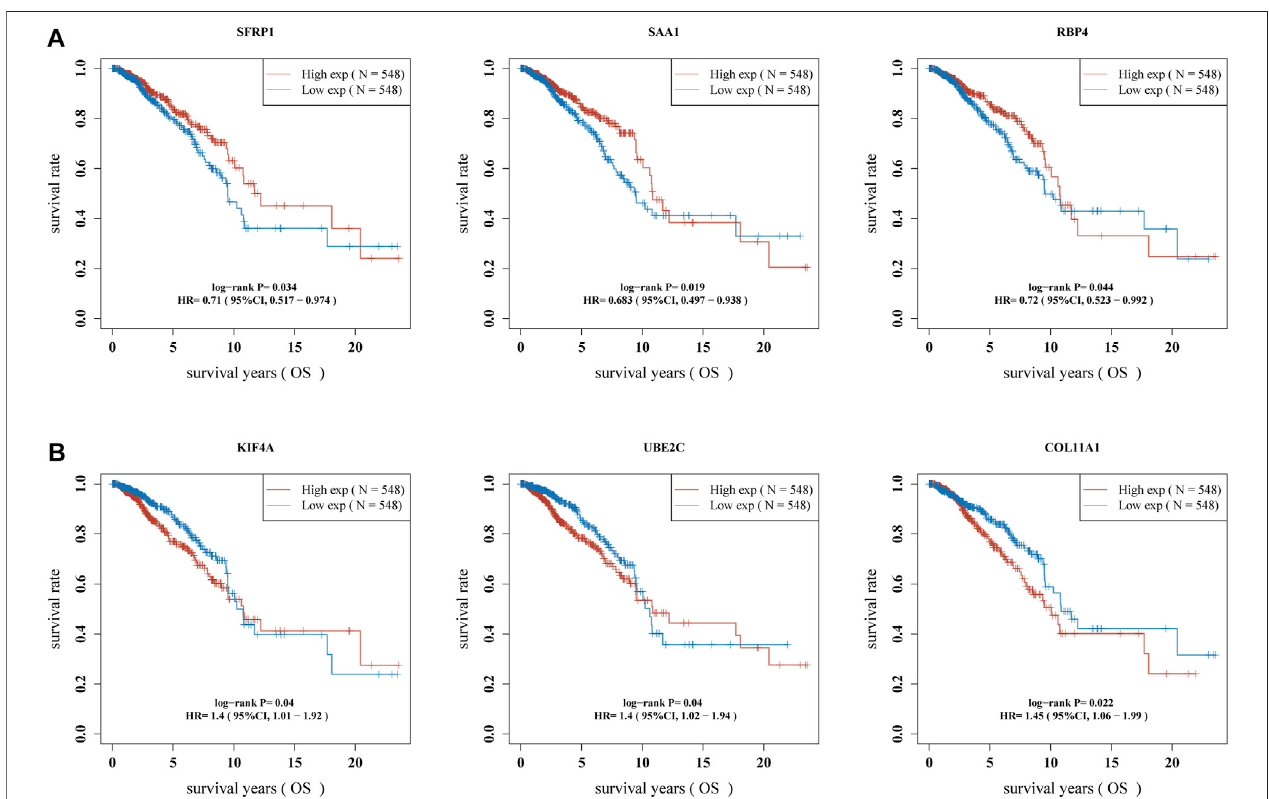
FIGURE3| Identi fi cationofsurvival-relatedDGEsinBCpatients. (A) highexpressionofSFRP1,SAA1andRBP4wereassociatedwithfavorablelong-termsurvival in BC patients. (B) High expression of KIF4A, UBE2C and COL11A1 was associated with poor prognosis in BC patients.